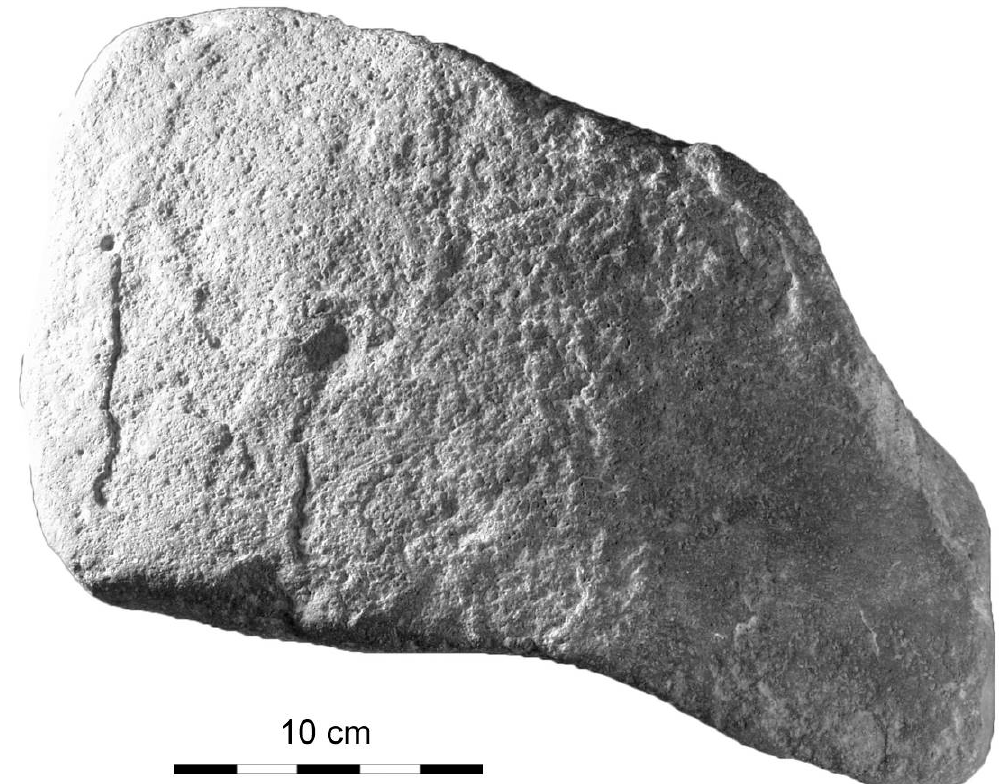
Figure 9. The grinding stone from Floor II, Loc. 1. Cereal starch grains were found on this stone, and charred cereal grains were found around it (see text for